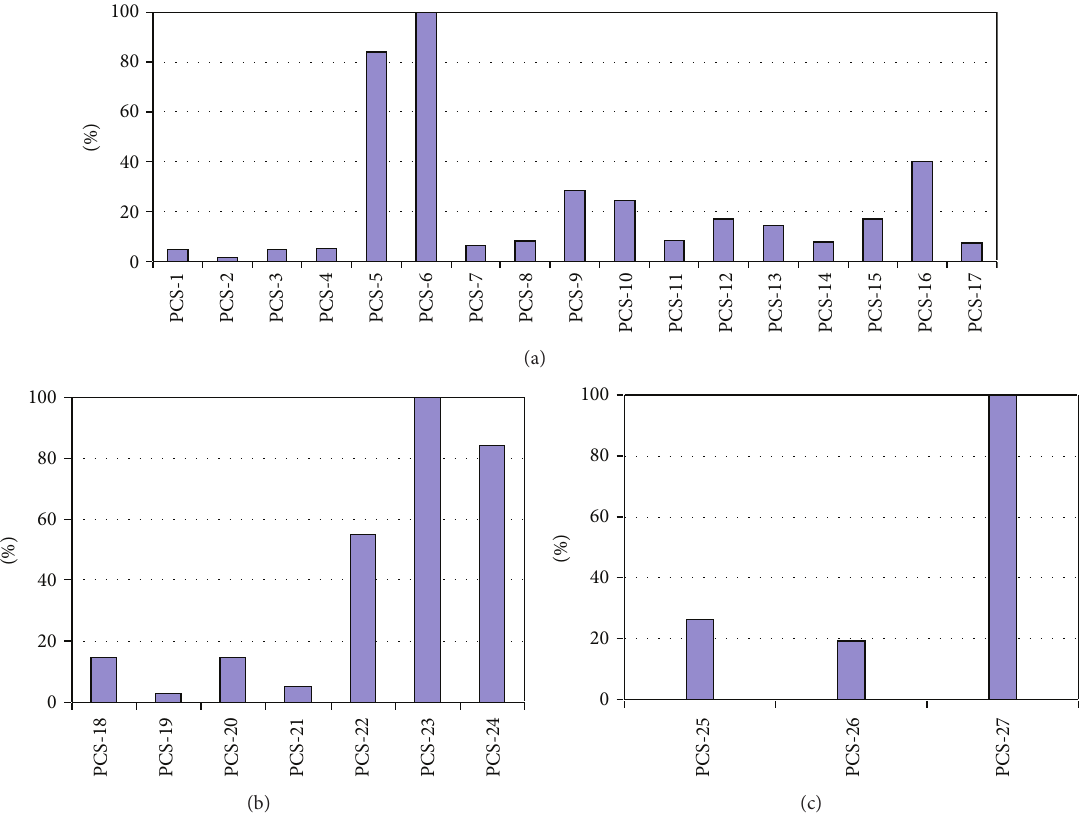
Figure 2: Relative activity of PCS components: (a) nonpurified water subsystem components (PCS-i/PCS-6), (b) purified water subsystem components (PCS-i/PCS-23), and (c) additional water cooling subsystem components